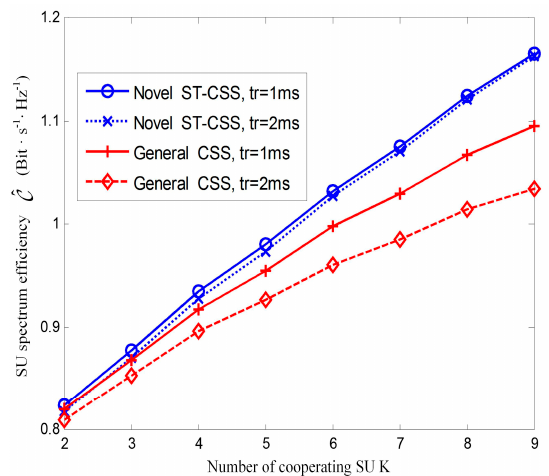
Figure 10. Spectral efficiency versus number of cooperating SU for the novel ST-CSS scheme and the general CSS scheme under different values of reporting time.